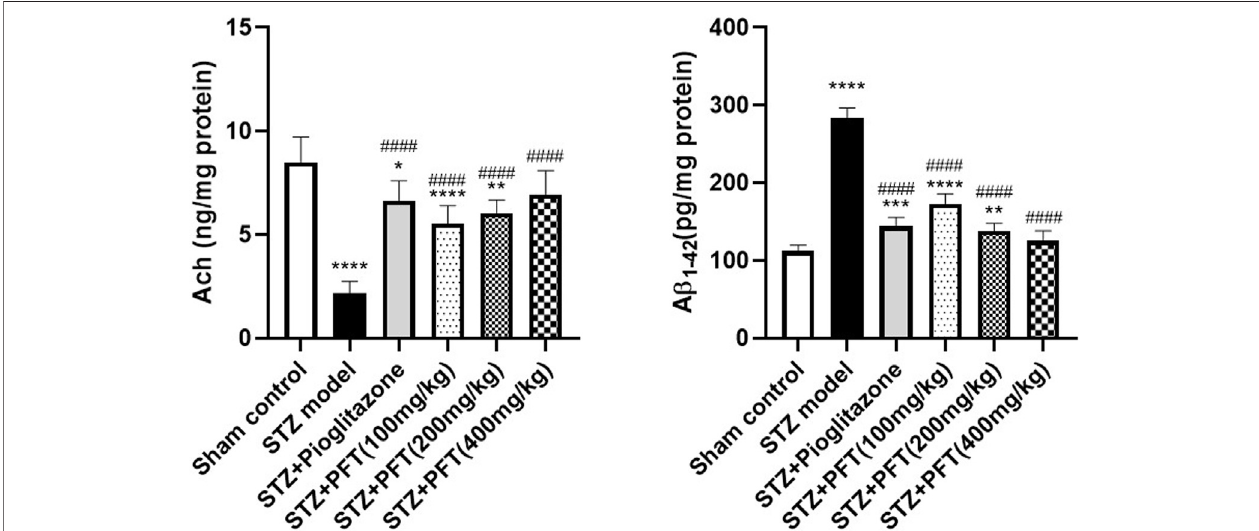
FIGURE2| PFToverturnedSTZ-inducedchangesinAchandA β 1-42 levelsinthehippocampus.Eachbarwithverticallinerepresentsthemean ± SDofsixmiceper group; *signi fi cantly different from the sham control group at p < 0.05, ** signi fi cantly different from the sham control group at p < 0.01, *** signi fi cantly different from the sham control group at p < 0.001, **** signi fi cantly different from sham control group at p < 0.0001, #### signi fi cantly different from the STZ group at p < 0.0001using One- Way ANOVA followed by Tukey ’ s multiple comparisons test.